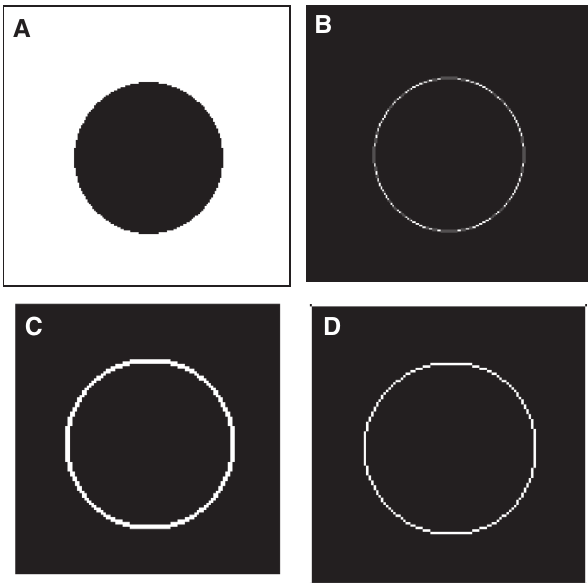
Figure 3. TFN based edge